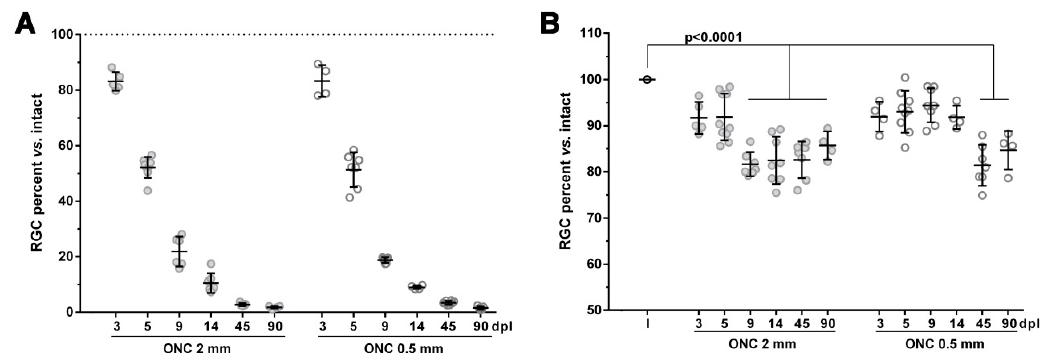
Figure 1. Retinal ganglion cell loss in injured and contralateral retinas: influence of the lesion distance. Scatter graphs showing the percent versus intact (100%, dotted line in ( A ); I in ( B )) of surviving retinal ganglion cells (RGCs). Black lines indicate the mean percent ± standard deviation. ( A ) In the injured retinas and in both experimental paradigms, RGC death was first significant at day 3, progressed steeply up to 14 days, and slowly thereafter. There were no significant differences between optic nerve crush (ONC) 0.5 mm and ONC 2 mm at any time point. ( B ) In the contralateral retinas, there was a significant decrease of RGCs at day 9 in the ONC 2 mm group, which did not progress further. In the ONC 0.5 mm group, RGC loss reached statistical significance at 45 days, and it also did not progress at 90 days. Statistics: one-way ANOVA, Kruskal–Wallis, Dunn ′ s multiple comparisons tests. See Table 1 for more details. dpl: days post-lesion.